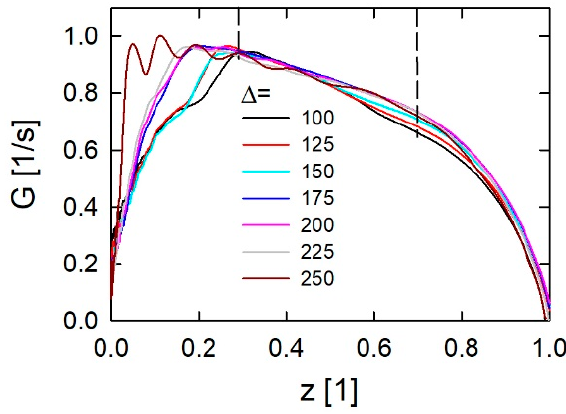
Figure 7. Plots of G ( z ) functions.